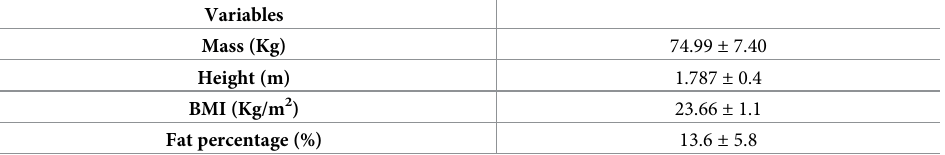
BMI: body mass index; kg: kilogram; m: